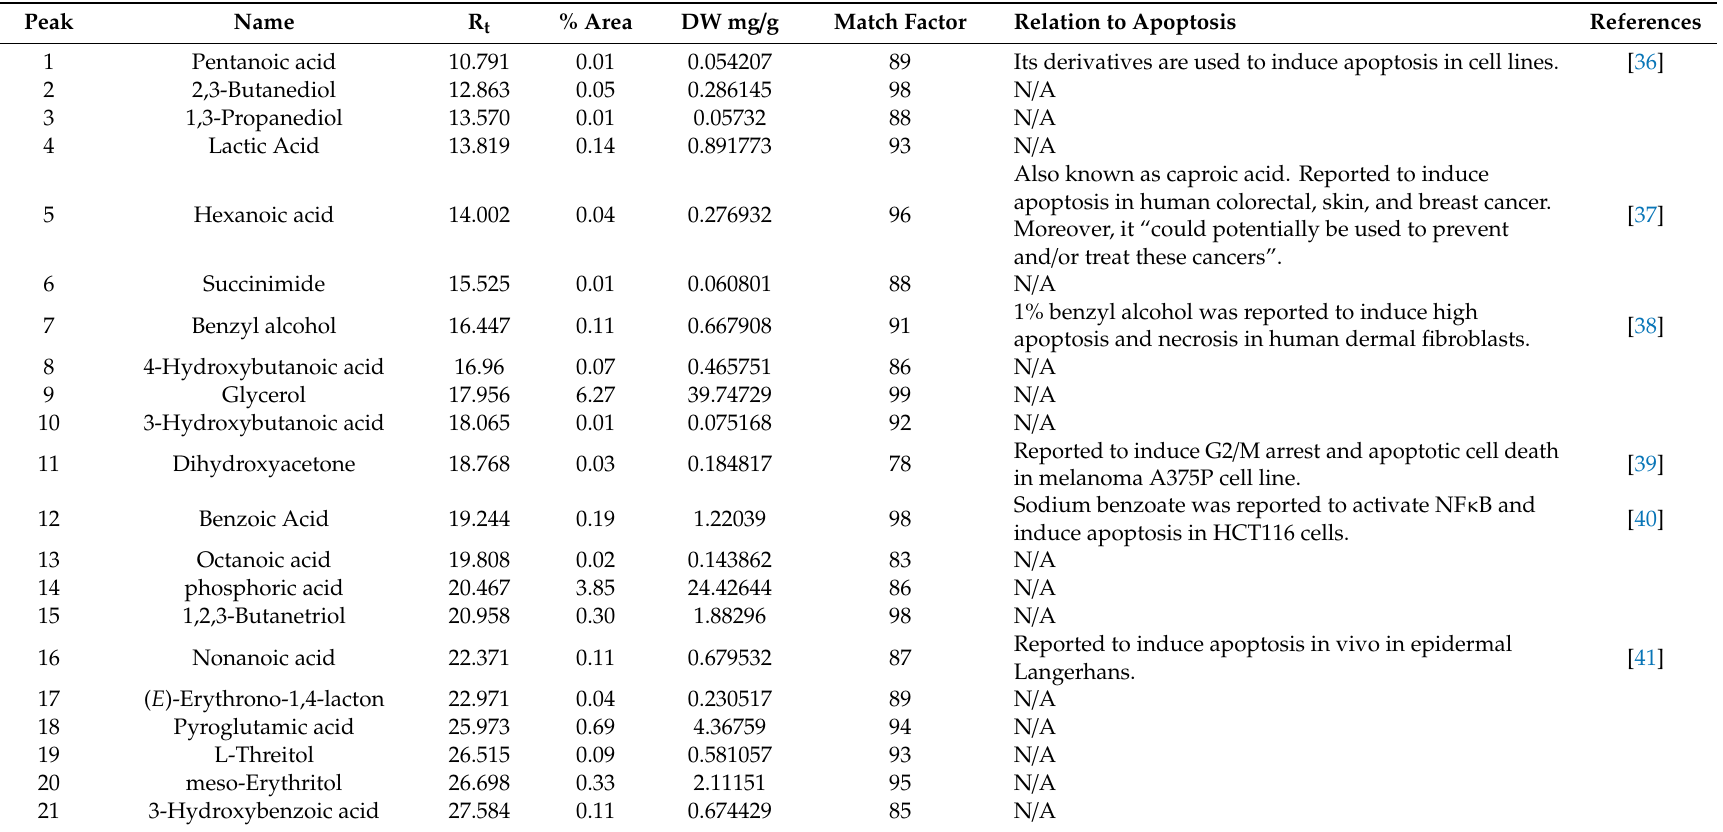
Table 1. Phytochemical profile of HTE and their association with anti-cancer, apoptosis induction, or cell cycle arrest activity.